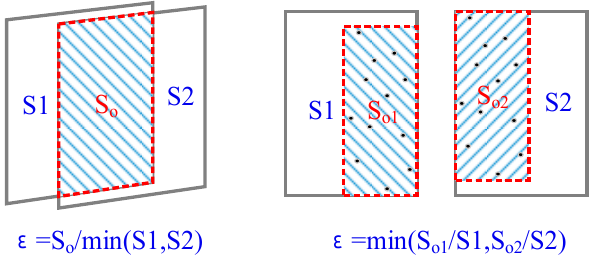
Figure 1. The schematic diagram of multi-view graph network structures. A node represents images of the scene. Arc represents stereo matching from start image i to end image j with bound disparity map (cid:1830) (cid:3036)(cid:3037) . Path represents correspondence linking between two images. Overlap ratio and intersection angle are then used to determine the candidate stereo pairs. The overlap ratio can be defined in two ways as illustrated in Figure 2.